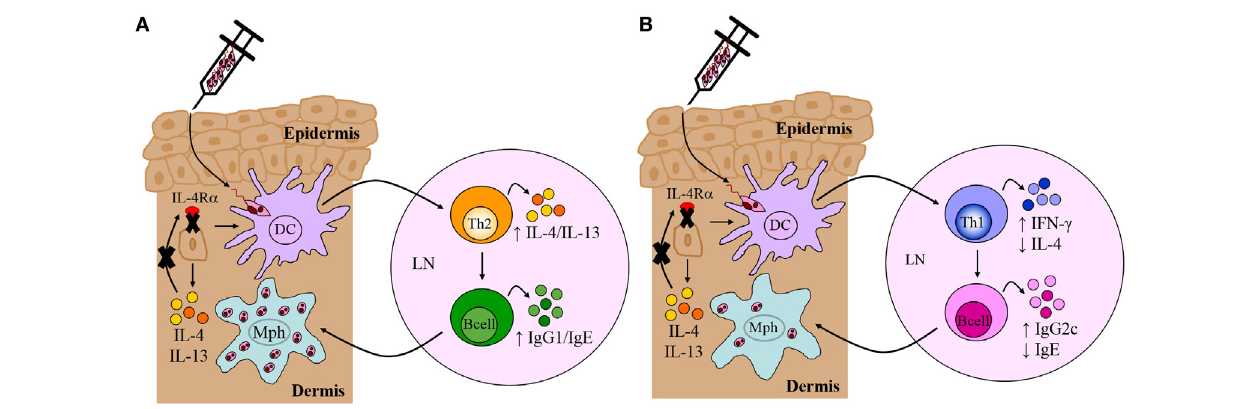
FiGURe 5 | Immune response in Leishmania major -infected BALB/c and C57BL/6 mice deficient for interleukin-4 receptor alpha (IL-4R α )-responsive keratinocytes. (A) Th2/Type 2-mediated susceptibility in BALB/c mice deficient for IL-4R α -responsive keratinocytes. KRT14 cre IL-4R α − /lox BALB/c mice, generated by cre/ lox P targeting, developed non-healing disease to experimental L. major LV39 and IL81 infection in the footpad, characterized by substantial interleukin-4 (IL-4)/ interleukin-13 (IL-13) production and IgG1/IgE production, similar to littermate control BALB/c mice. Model prepared using information from submitted manuscript. (B) Th1/Type 1-mediated protective immunity in C57BL/6 mice deficient for IL-4R α -responsive keratinocytes. Similar to control C57BL/6 mice, KRT14 cre IL-4R α − /lox C57BL/6 mice, generated by cre/ lox P targeting, controlled lesion development upon L. major LV39 and IL81 infection in the footpad or ear dermis, characterized by strong IFN- γ and IgG2c production and concomitantly reduced IL-4 and IgE (103). DC, dendritic cells; Mph, macrophage; LN, lymph node; Th1, T helper 1; Th2, T helper